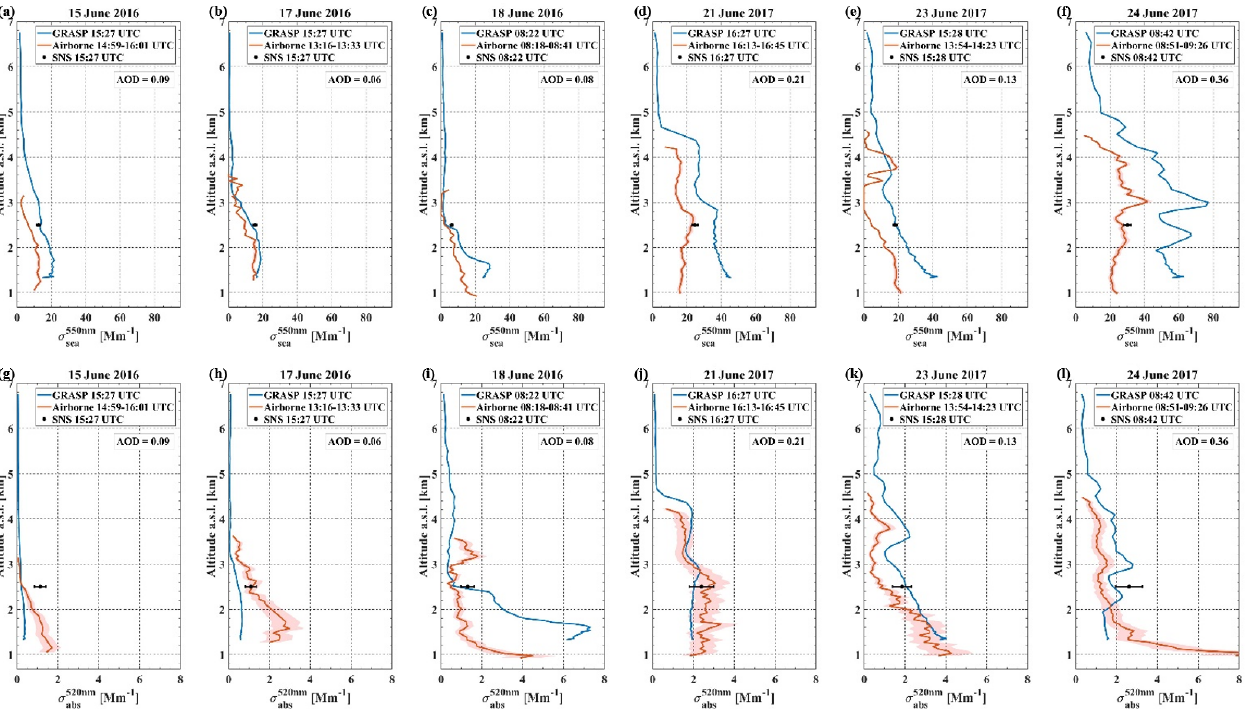
Figure 5. Scattering ( σ sca ) and absorption ( σ abs ) coefficients at 520nm retrieved by GRASP (blue), aircraft (red), and the SNS (black) in situ measurements on (a, g) 15, (b, h) 17, and (c, i) 18 June 2016 and (d, j) 21, (e, k) 23, and (f, l) 24 June 2017. The AOD shown is at